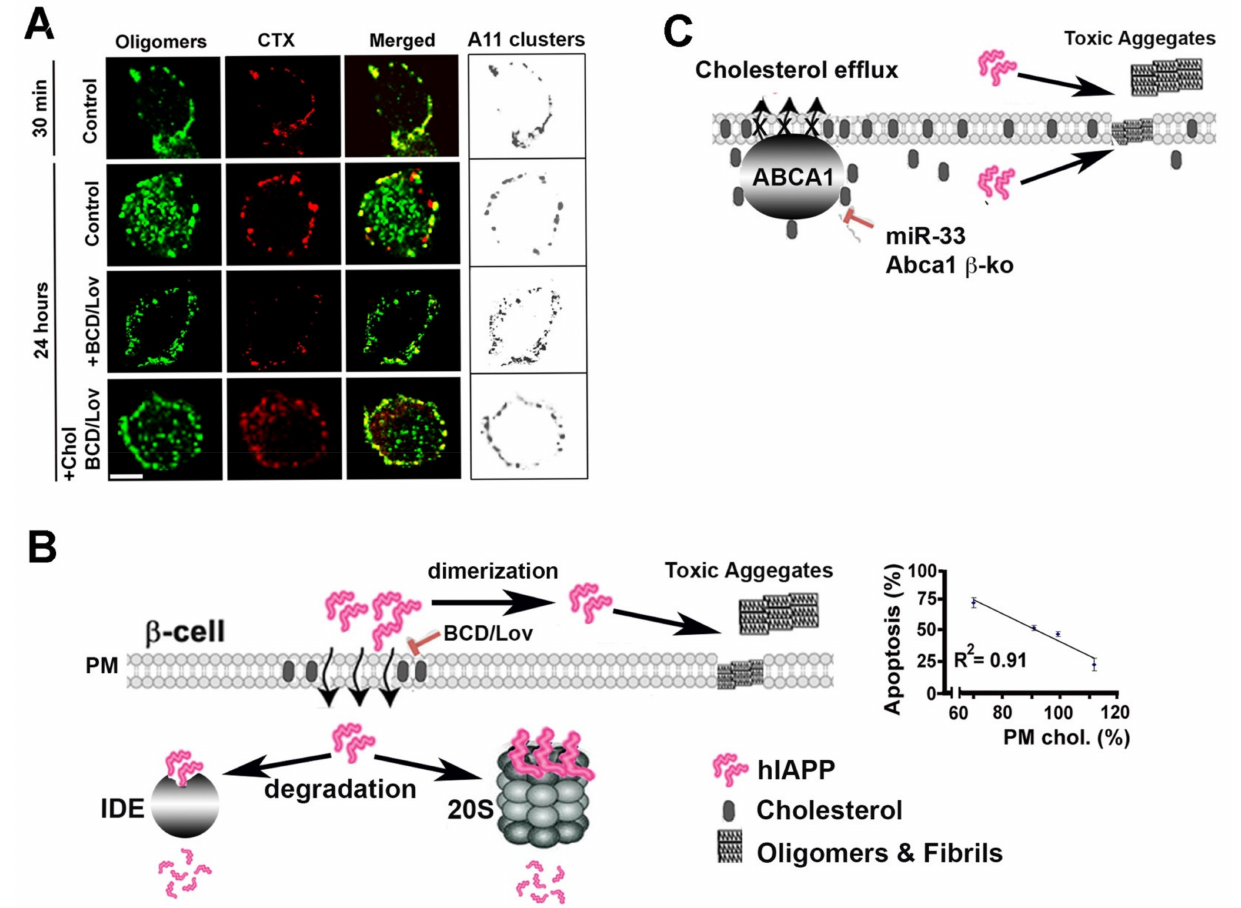
Figure 5. Cholesterol controls hIAPP trafficking, aggregation and toxicity in pancreatic